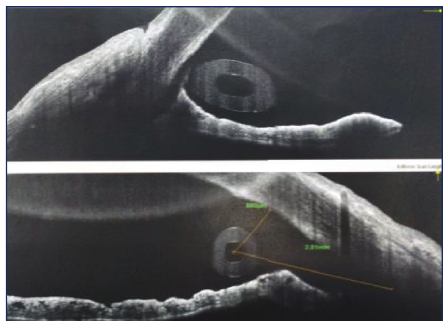
Figure 6: AS-OCT imaging 4 months after surgery of a male patient in group I IOP was 14mmHg with representation of the tube opening in the AC, angle patency, and